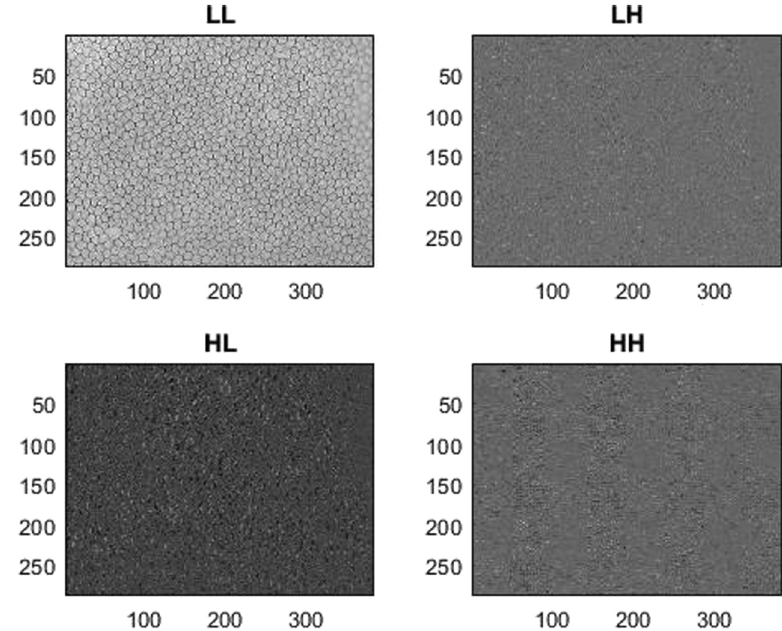
Figure 7: Sub - bands LL, LH, HL, and HH.